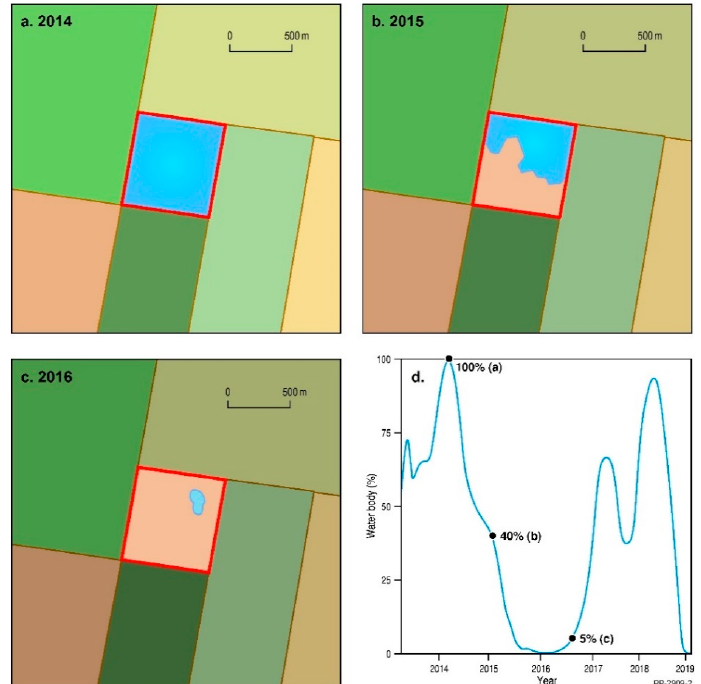
Figure 3. Conceptualisation of the time series extraction for each polygon. ( a – c ) At each individual time step, the percentage surface area of water (indicated in blue) within each waterbody polygon (outlined in red) was calculated, producing a time series ( d ) of the change in surface water extent for each waterbody since 1987.